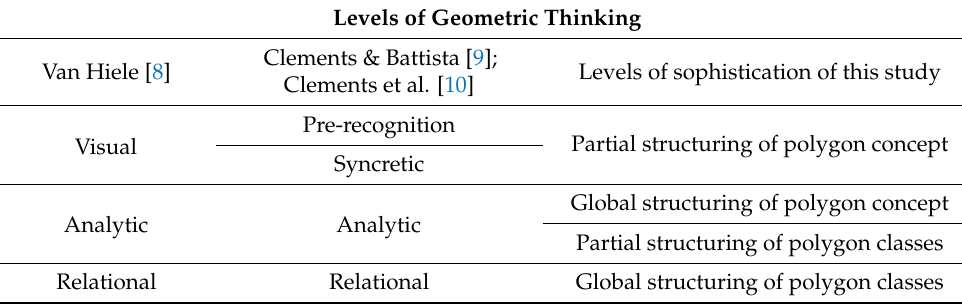
Table 2. Levels of sophistication of polygon concept and polygons